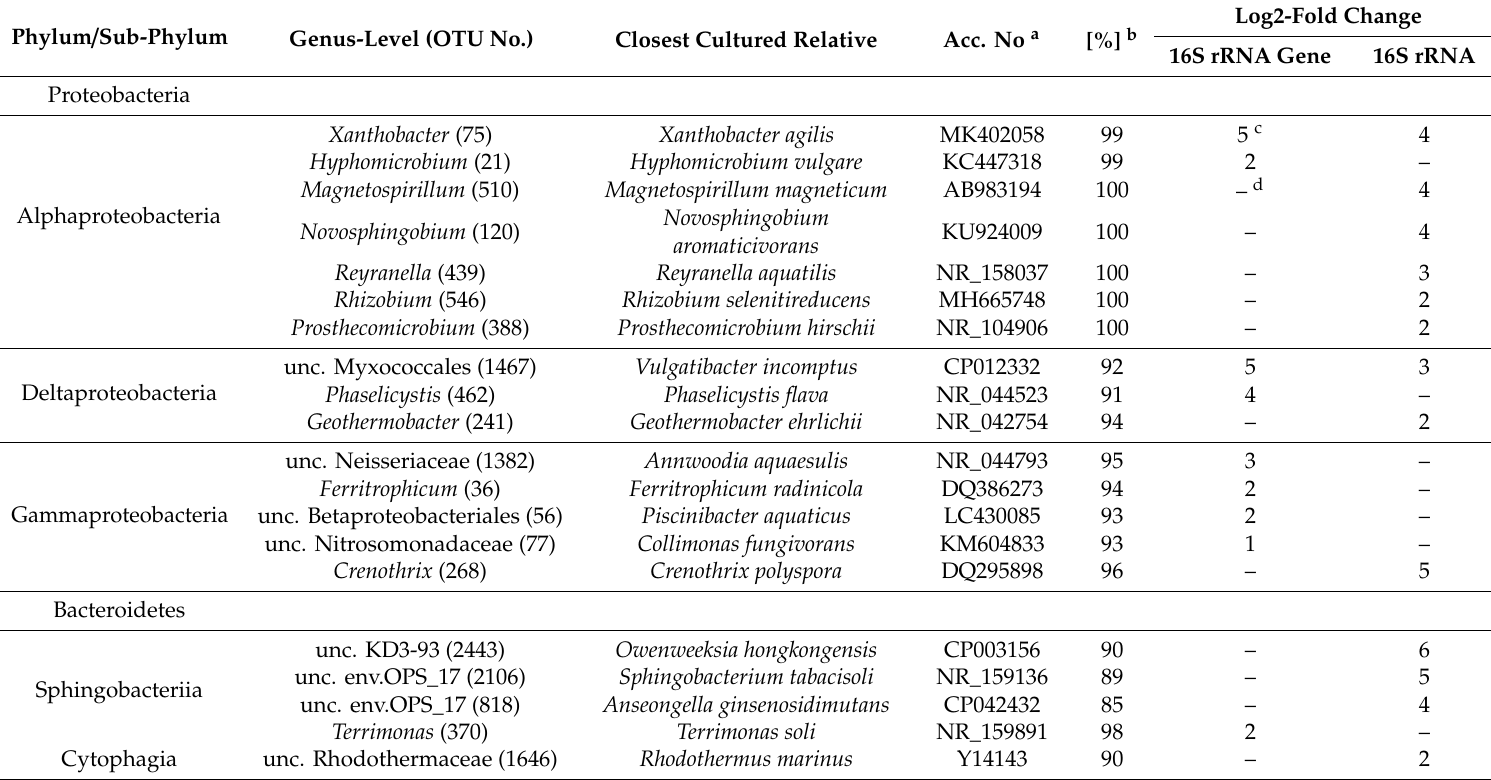
Table 1. Bacterial genus-level taxa (OTUs) enriched in TrOC-amended sediments relative to unamended controls, and closest cultured relatives of the OTU representative 16S rRNA gene sequences. Significant ( p -adj < 0.05) Log2-fold changes > 0 are reported as determined by